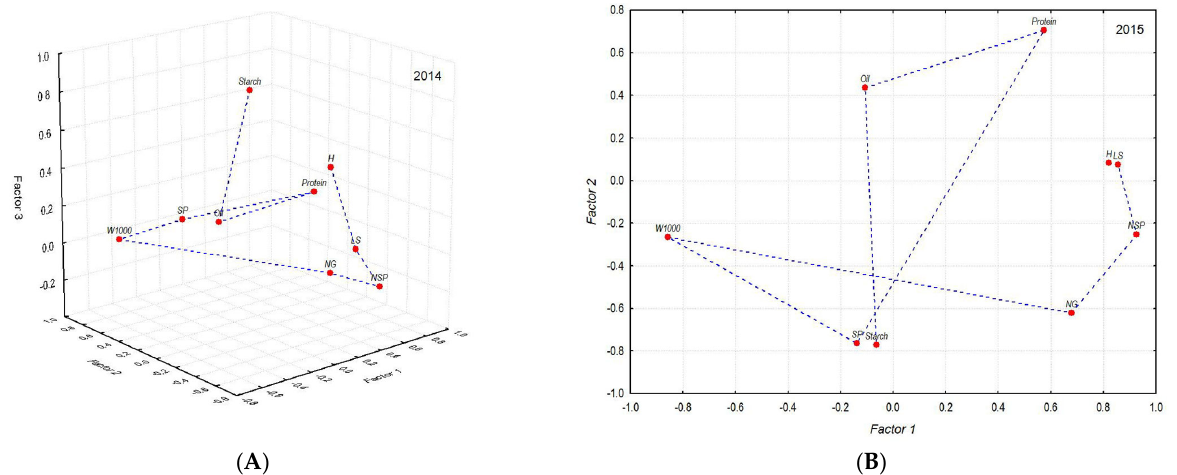
Figure 3. Factor structure of the variation of the studied indicators in 2014 ( A ) and 2015 ( B ).